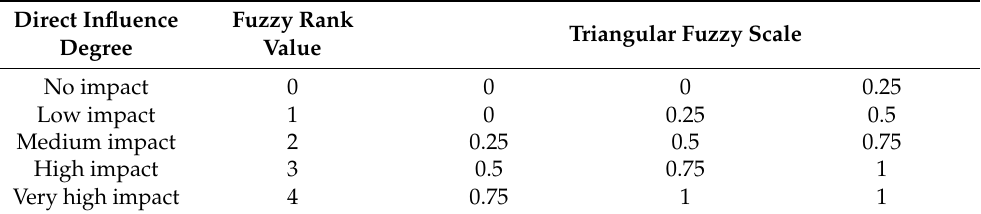
Table 3. Direct fuzzy influence degree and corresponding triangular fuzzy